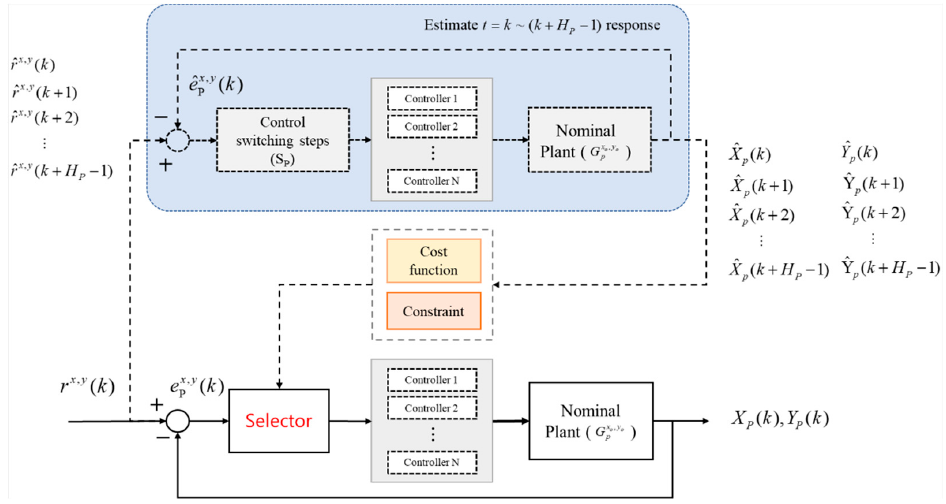
Figure 1. The multiple switching control structure.